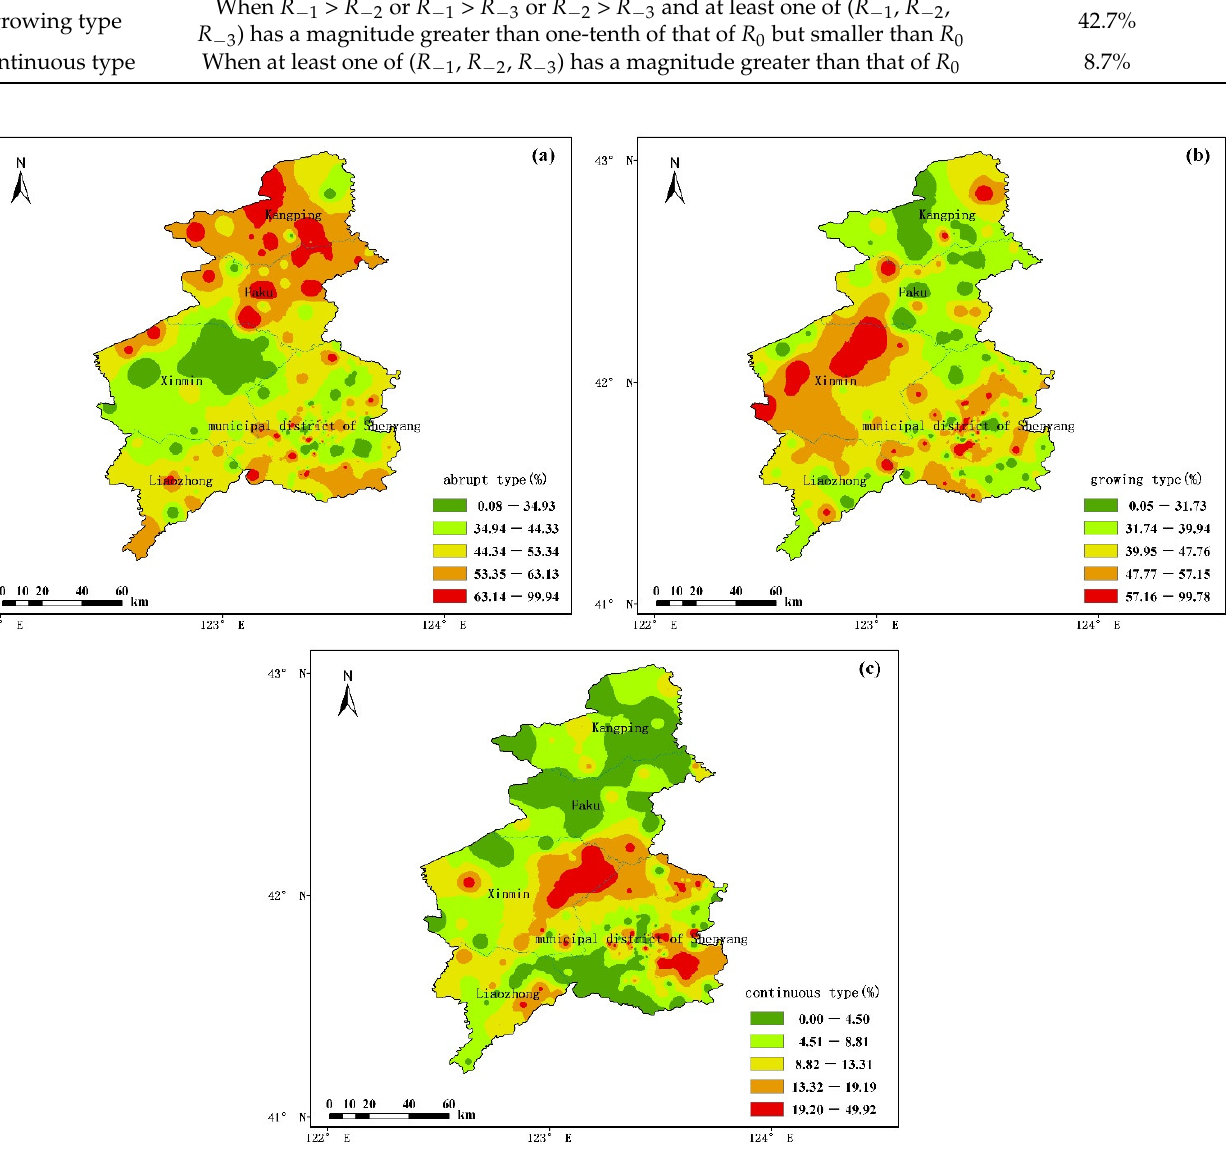
Figure 9. Spatial distributions for ExHP events of the ( a ) abrupt type, ( b ) growing type, and ( c ) continuous type in Shenyang.